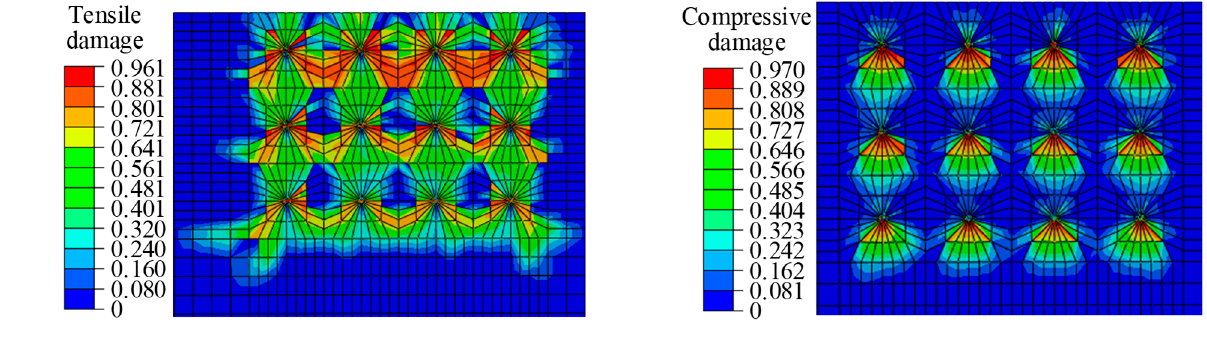
Figure 14. Concrete damage of S-1 and S-2.